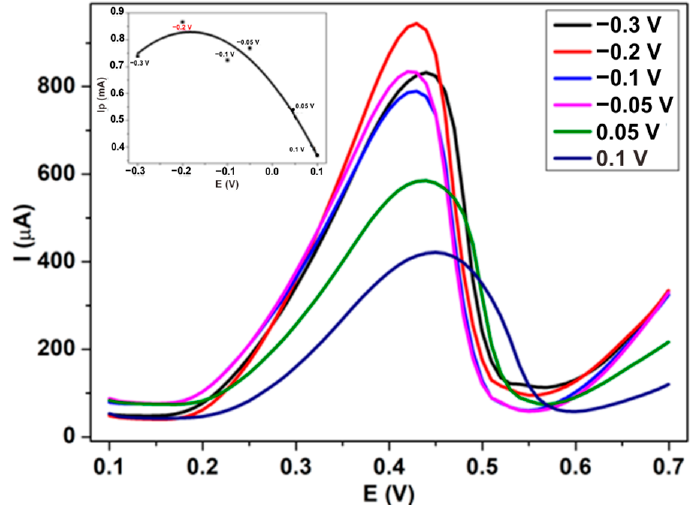
Figure 2. ( a ) Cyclic voltammograms of Au nanostructured-modified SPCE in a 0.5 M H 2 SO 4 solution. Inset shows the correlation curve between the reduction peak current with electrodeposition applied potential; ( b ) ECSA value for each SPCE with different electrodeposition applied potential.